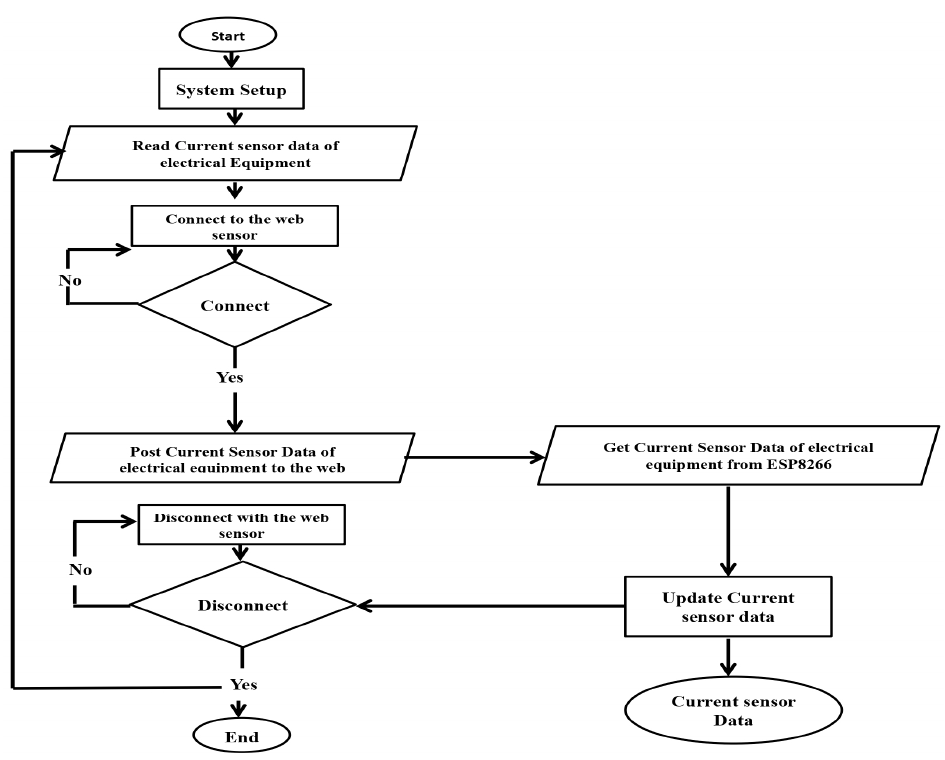
Figure 11. Flowchart system.